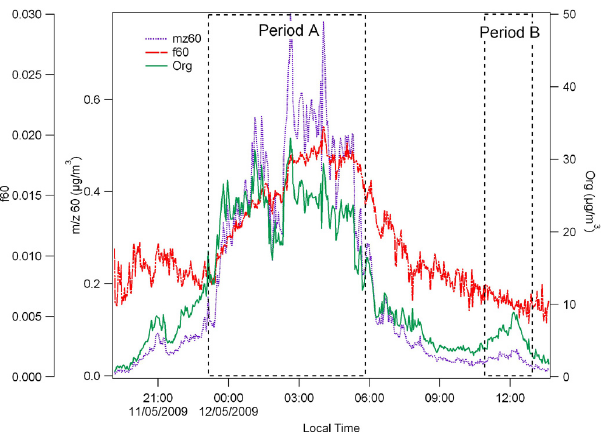
Fig. 2. The organics mass concentration, m/z 60 (used as a marker for wood burning) and f 60 ( m/z 60 normalized by the organics) plotted as a function of time, including the burning event as well as during the following day. Local time is